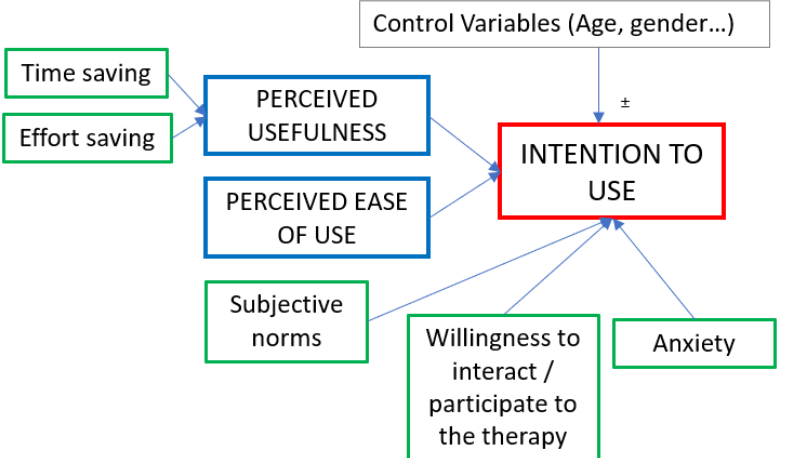
Figure 2. Structure of the TAM. Light blue variables are those of the core of the model, and gray variables are those that we added for our specific study. The dark-blue box represents the output (i.e., the predicted